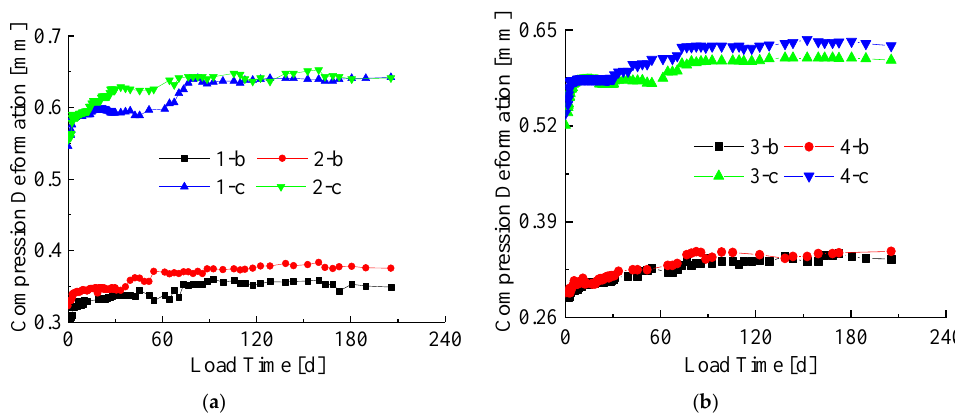
Figure 7. Creep-time curves under the same cross-section condition (with initial displacement): ( a ) Section size of 110 mm × 110 mm; ( b ) Section size of 130 mm × 130 mm.